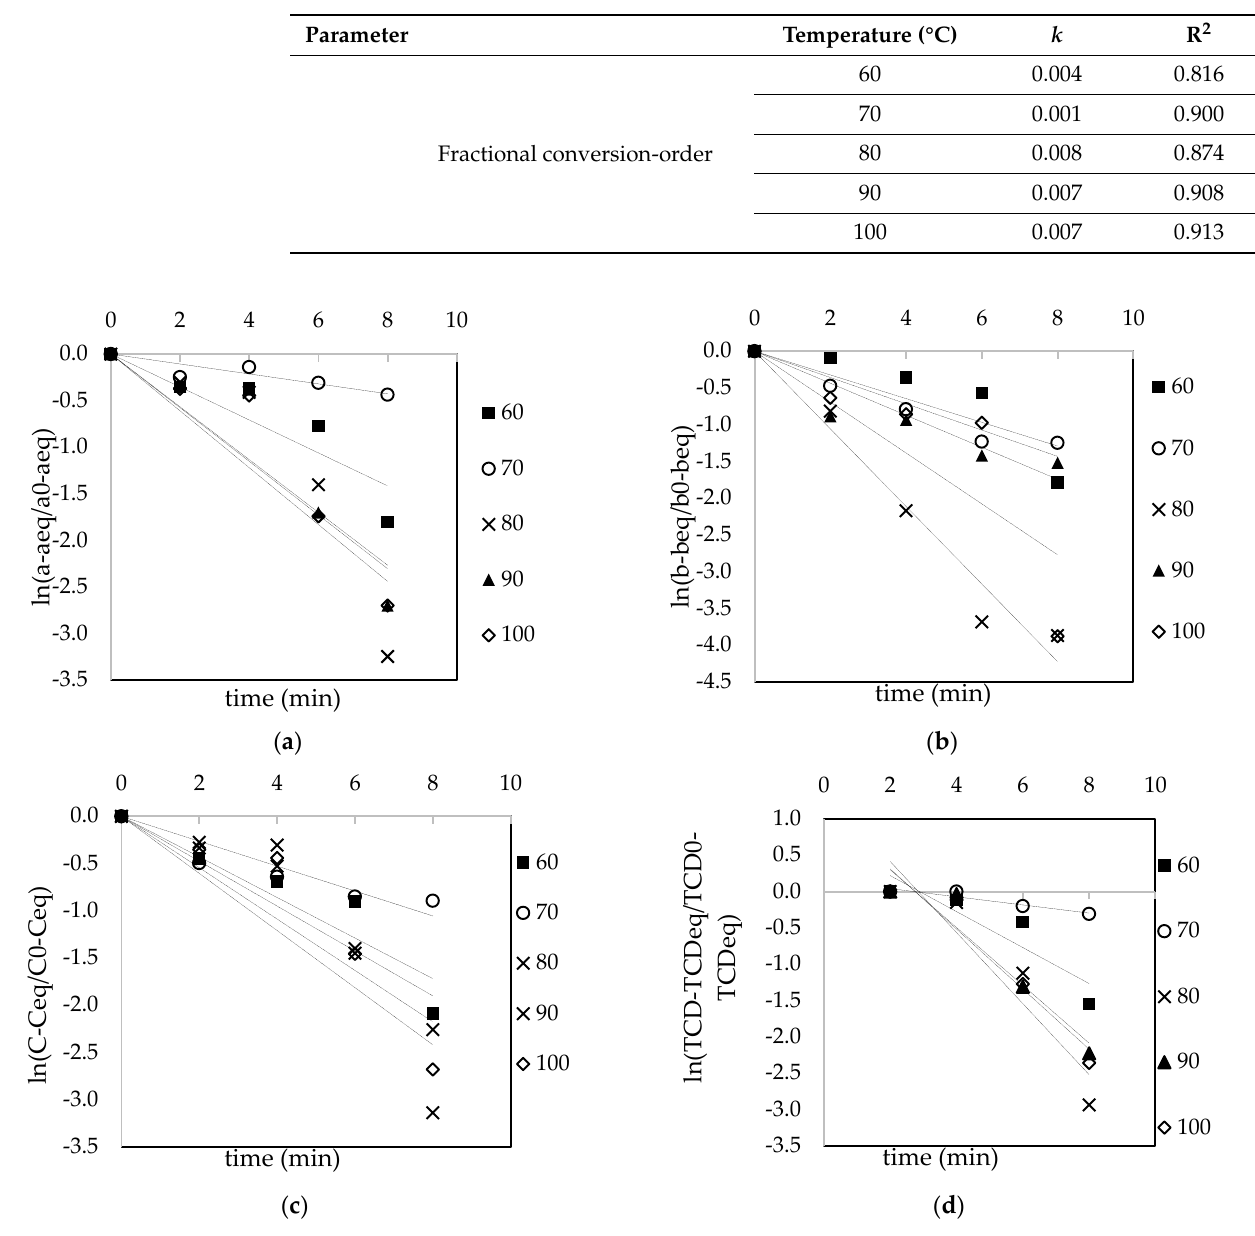
Figure 3. First-order kinetic model of the effect of blanching (60, 70, 80, 90 and 100 ° C) on the color parameters of Dabai fruit: ( a ) b *, ( b ) chroma, and ( c ) TDC .